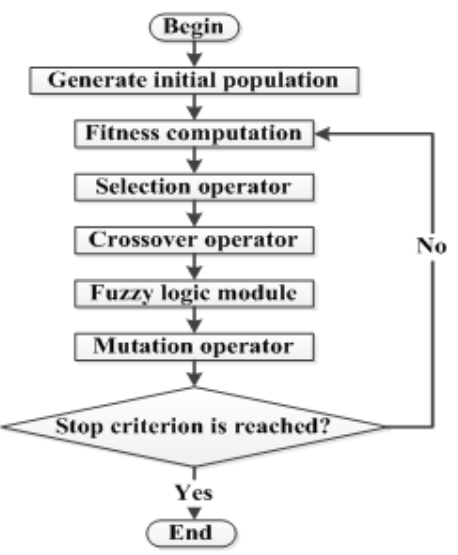
Figure 2. The flow chart of fuzzy logic genetic